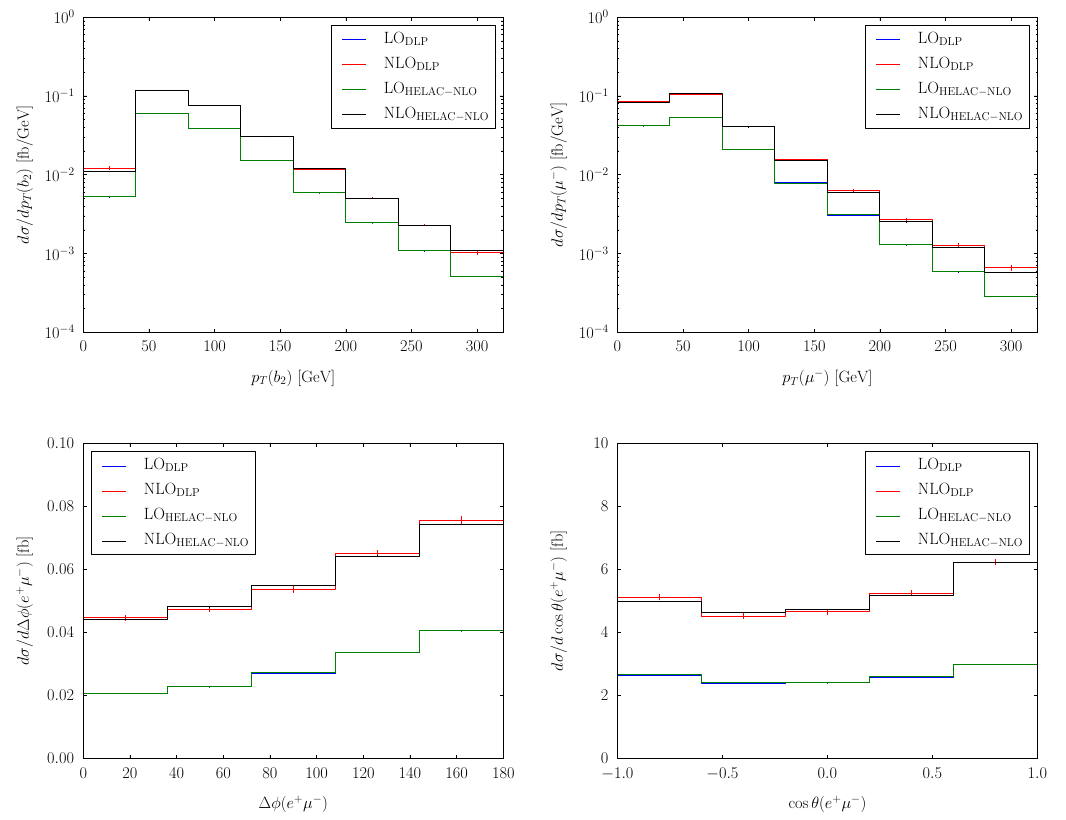
Figure 13 . Differential cross section distributions as a function of p T ( b 2 ) , p T ( µ − ) , ∆ φ ( e + µ − ) and cos θ ( e + µ − ) for the pp → e + ν e µ − ¯ ν µ b ¯ b b ¯ b + X production process at the LHC with Results are presented at LO and NLO for µ 0 = µ DLP . Comparison between Helac-Nlo predictions and results from ref. [25] (given with the subscript DLP) is shown. The NNPDF3.1 PDF sets are employed. Also displayed are Monte Carlo integration